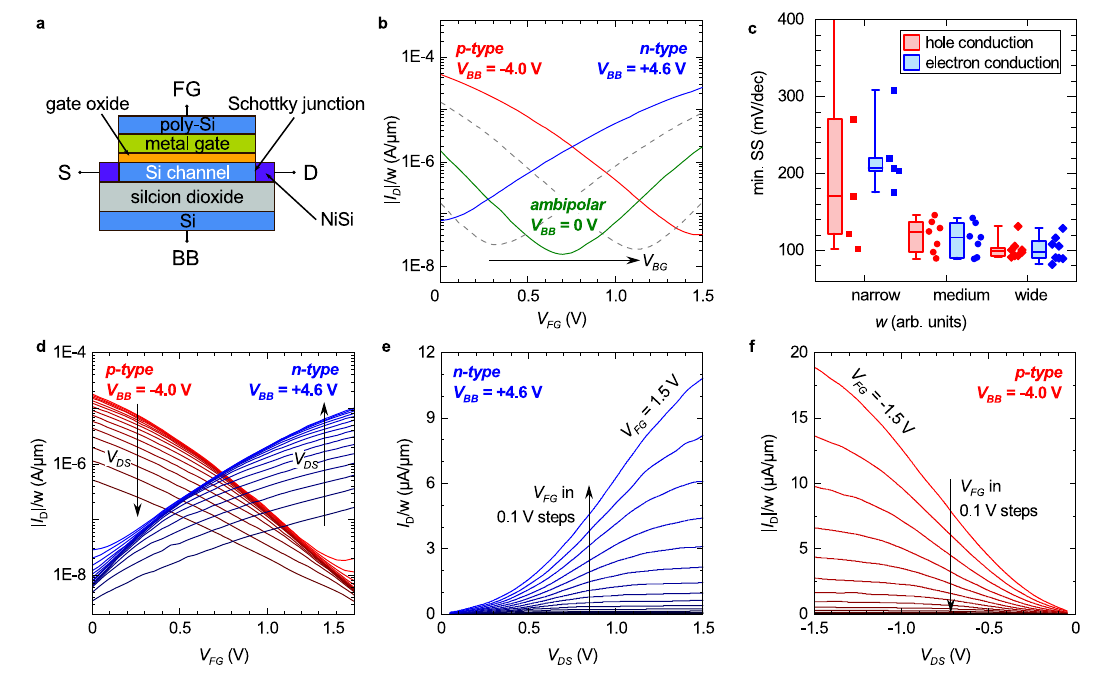
Fig. 1 | Back-bias recon fi gurable fi eld effect transistor(BB-RFET)integrated on 300mm wafers using 22nm FDSOI technology. a Schematic image of a single device with materials and contacts, comprising source (S), drain (D), front-gate (FG), and a back-bias (BB)contact. b Three distinct operation modes accessible by changingtheappliedback-bias( V BB ). c Distributionofminimalsubthresholdswing SS in ambipolar mode for V DS =0.1V measured at devices with varying width as